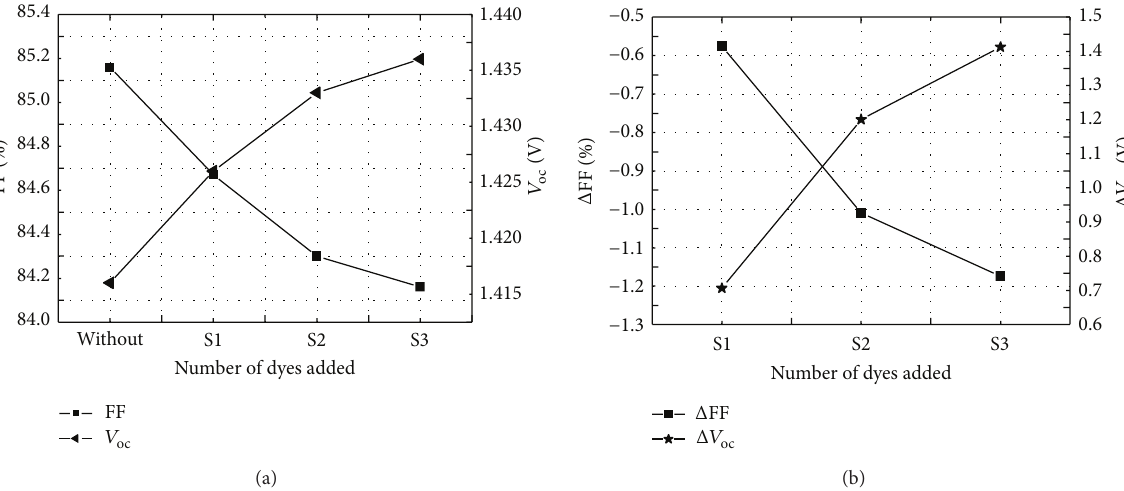
Figure 4: Simulation results of the variation of (a) fill factor and open-circuit voltage with the number of dyes added and (b) increase in fill factor and open-circuit voltage with the number of dyes